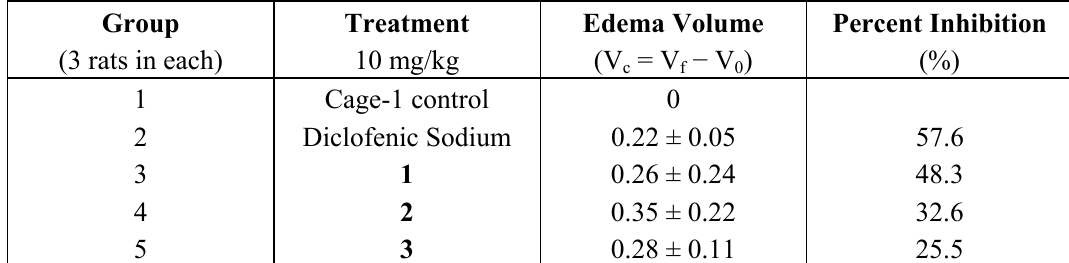
Table 2. Anti-inflammatory potential of compounds 1 – 3 in carrageenan induced paw edema of